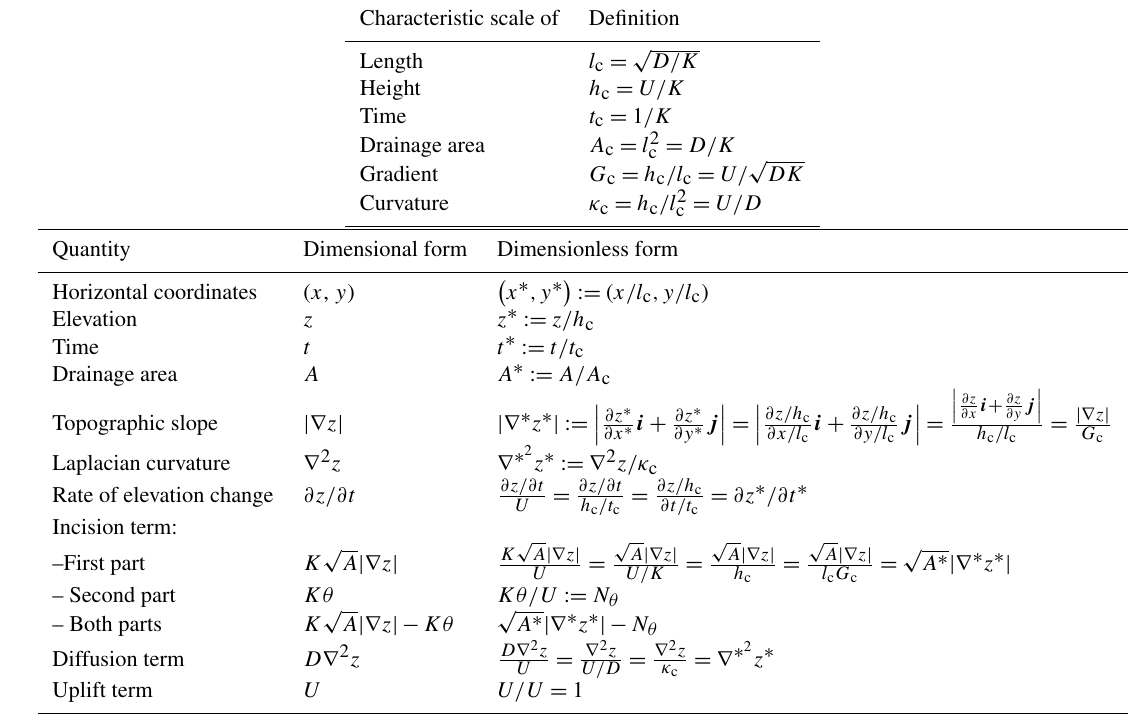
Table 2. Summary of characteristic scale definitions and of derivation of dimensionless quantities. Characteristic scale